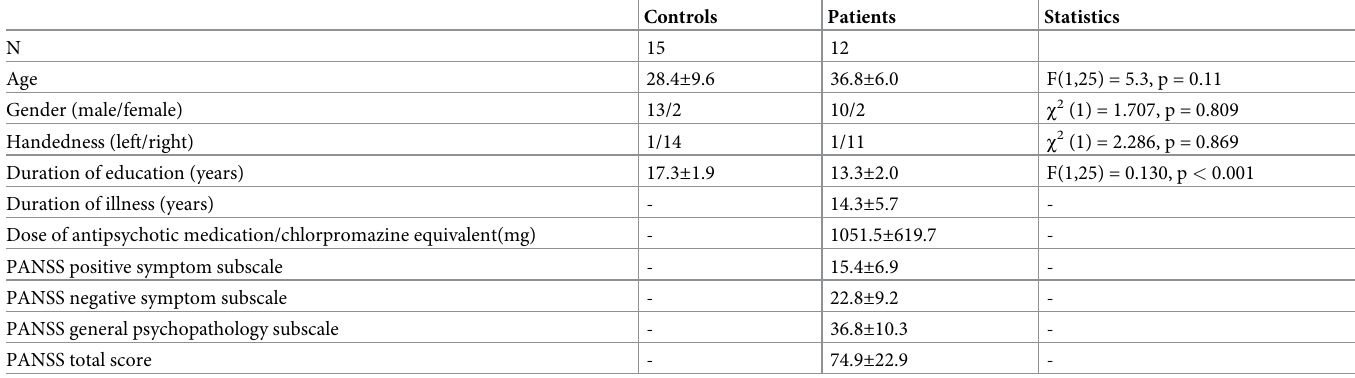
Table 1. Profile of sample